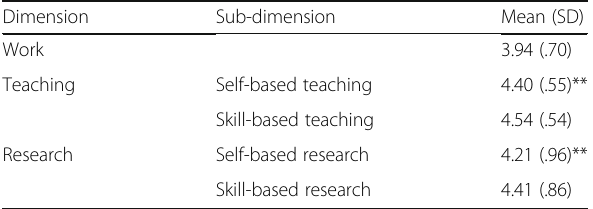
Table 8 Participant professional identity descriptives